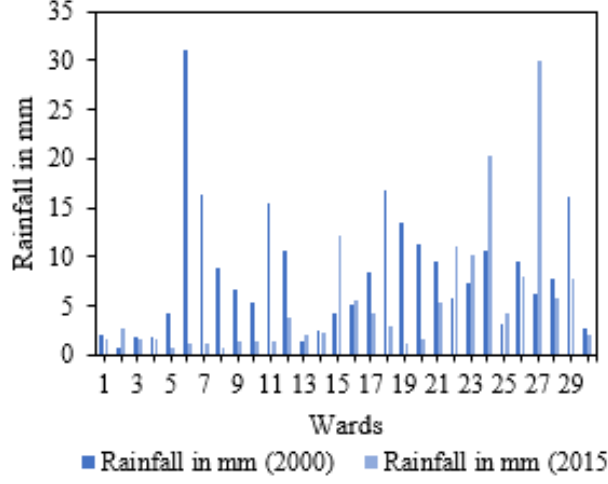
Figure 3. Annual rainfall situation of 2000 and 2015.